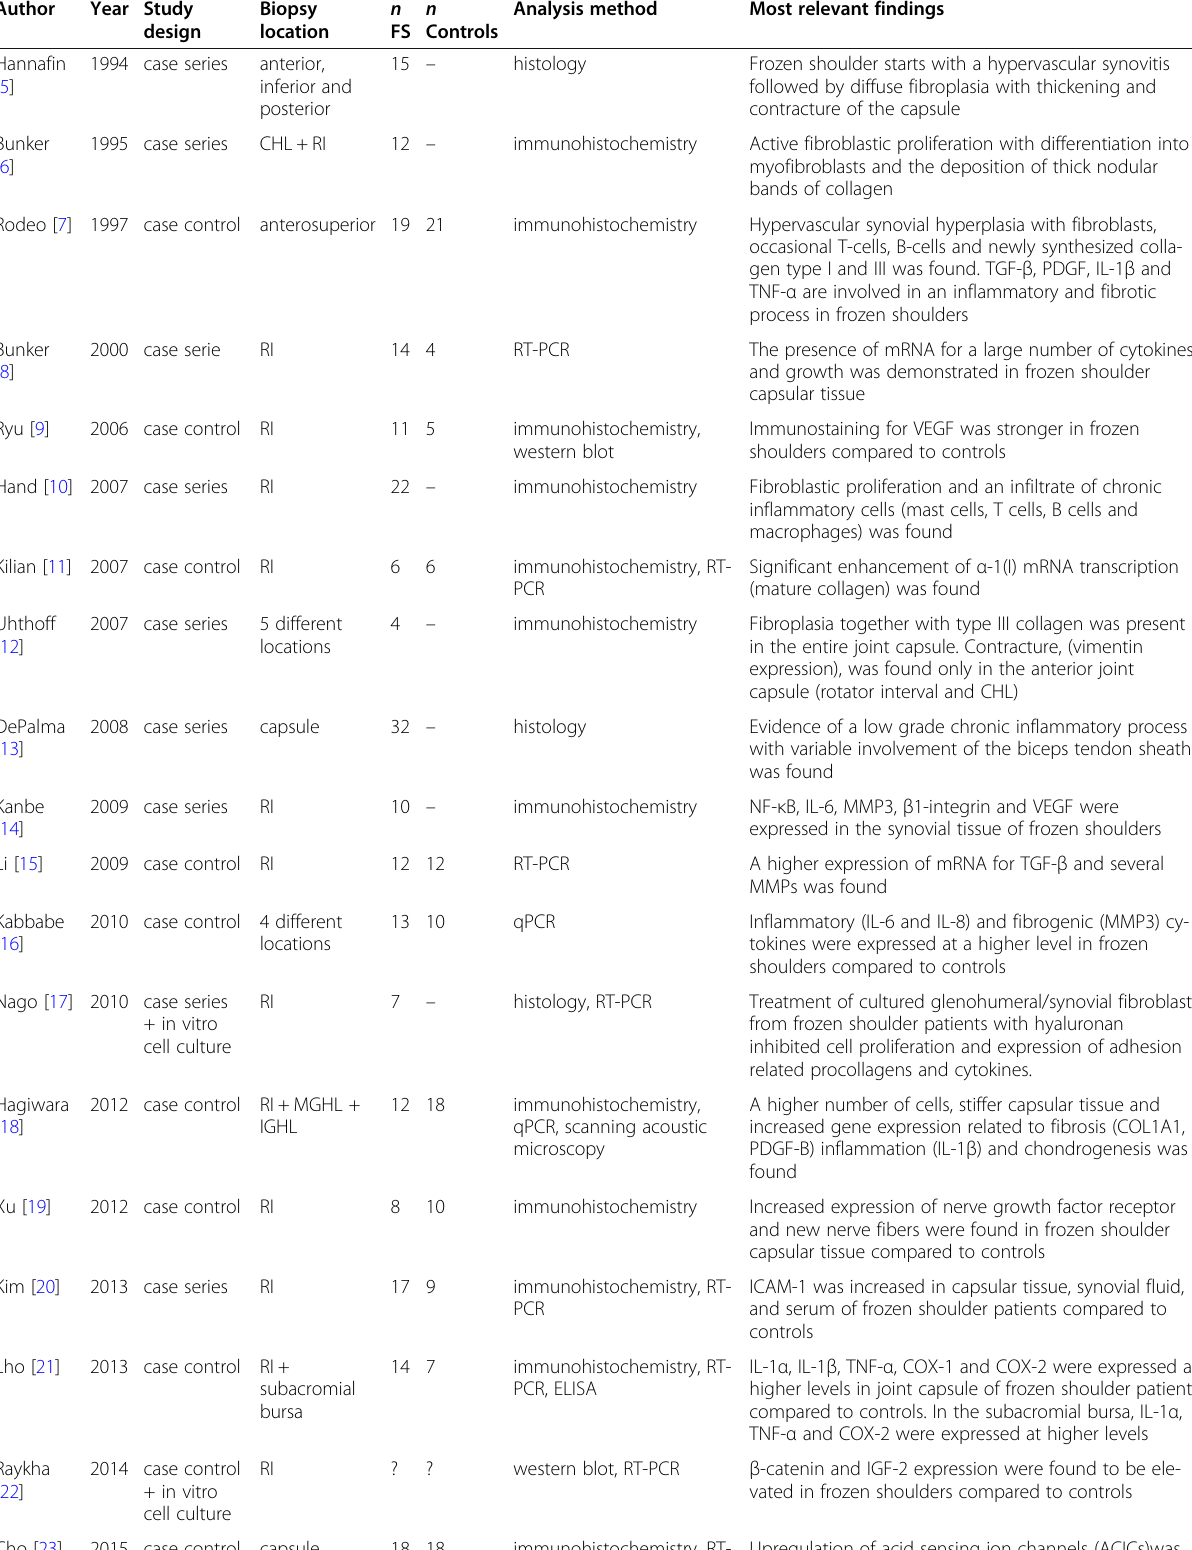
Table 1 Biopsy studies; studies investigating the pathophysiology of frozen shoulder with glenohumeral capsular tissue samples